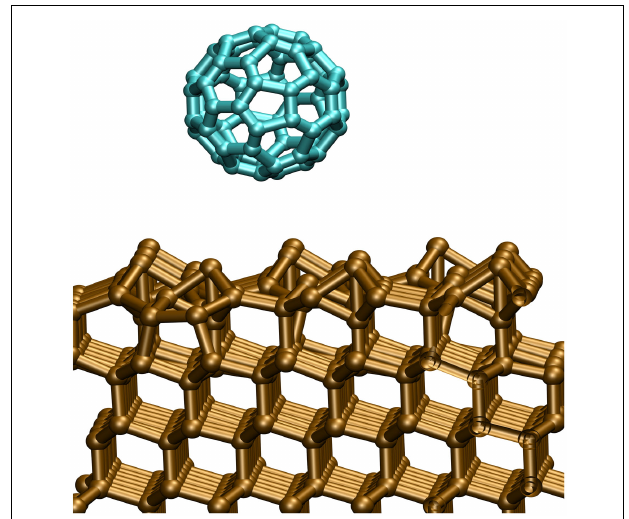
FIGURE 1 | Calculation supercell showing the reconstructed Si(111) 7 (cid:2) 7 surface . At some distance from the surface, we report the incoming C 60